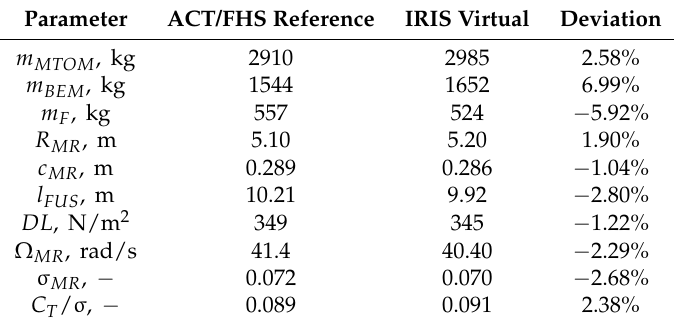
Table 5. Characteristic parameters of the reference configuration and the case study.